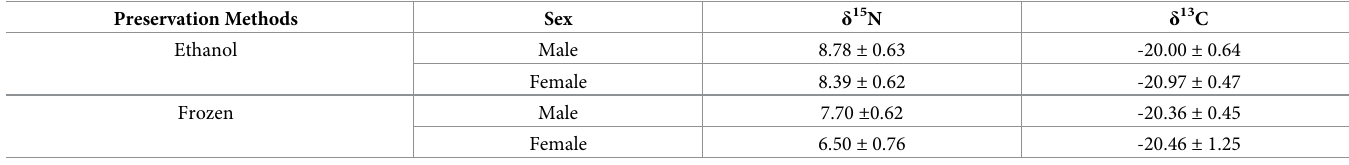
Table 1. Summary of isotopic data from the preservation experiment. Preservation